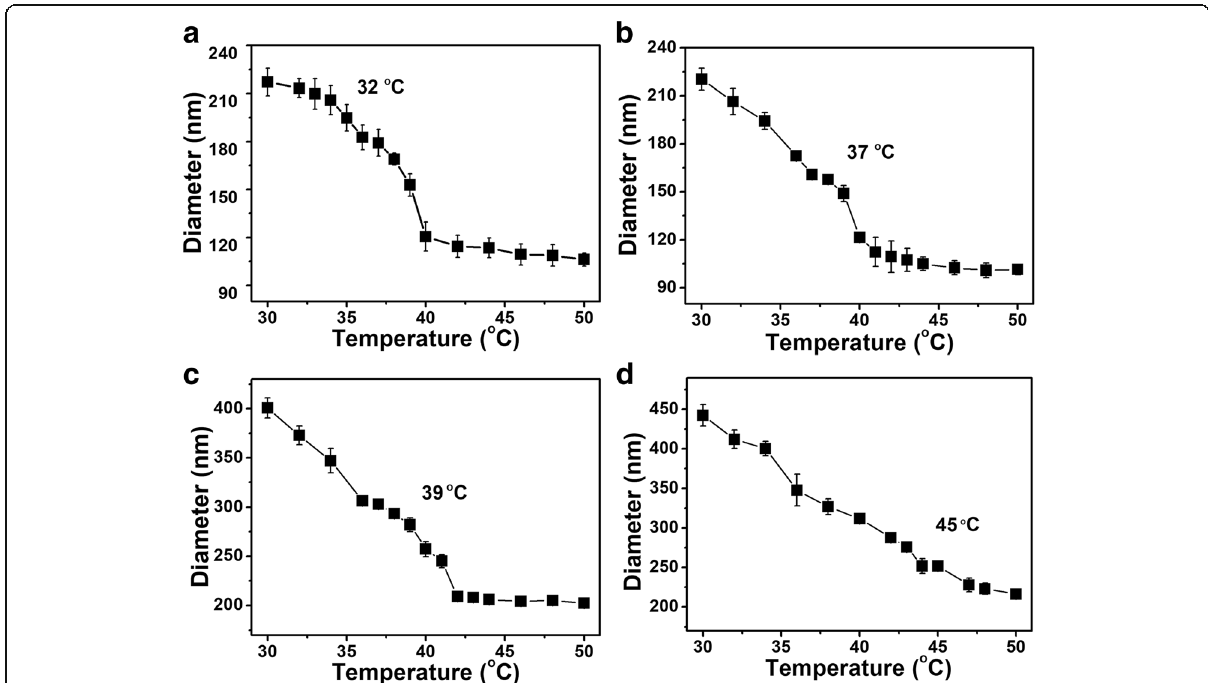
Fig. 3 Temperature dependence of the hydrodynamic diameters of a PNIPAM, b PNIPAM-co-AAc5, c PNIPAM-co-AAc10, and d PNIPAM-co-AAc20 nanogels at pH 7.4